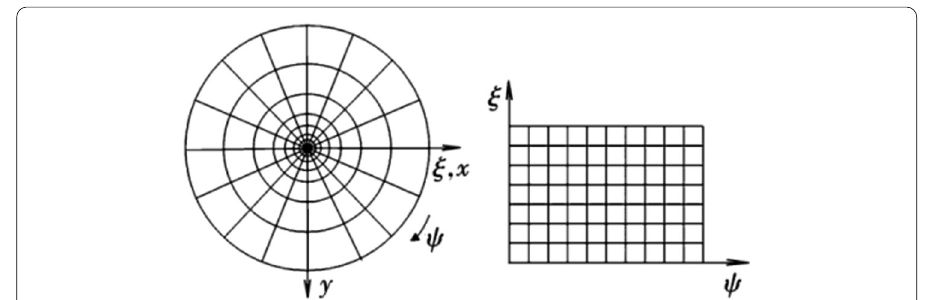
Fig. 1 Sketch map for Log‑polar transform